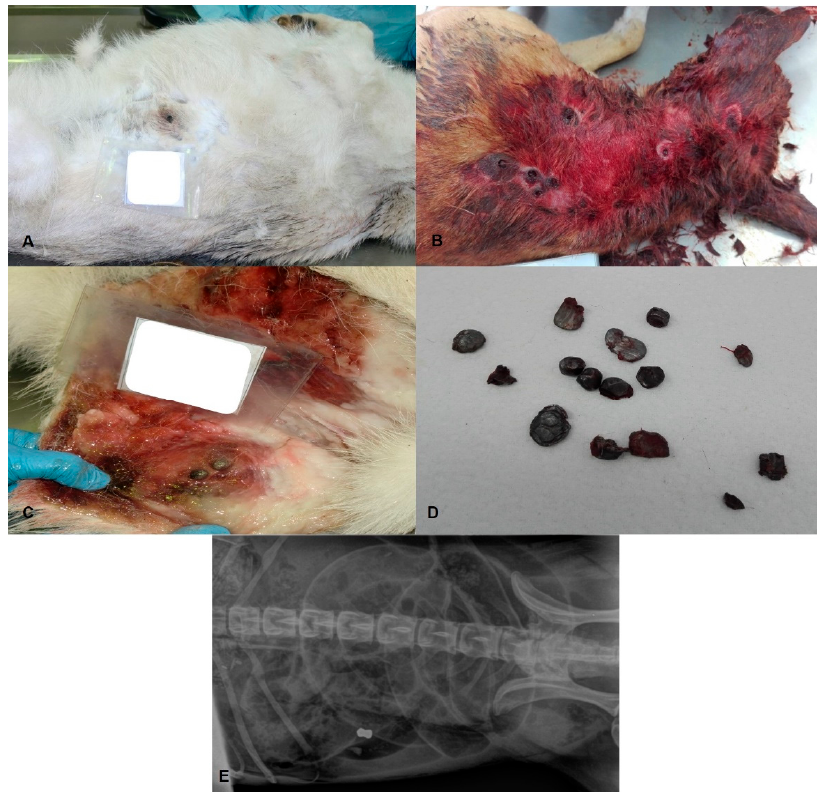
Figure 4. Dog. ( A ): Projectile injury caused by firearm with an exit hole in the abdomen in a senior, large-sized, female Siberian Husky; ( B ): Projectile injuries in an adult, medium-sized, male Poodle shot down during hunting; ( C , D ): Firearm projectiles collected at necropsy; ( E ): Radiography showing a projectile that reached the intestine in a medium-sized, male Poodle.